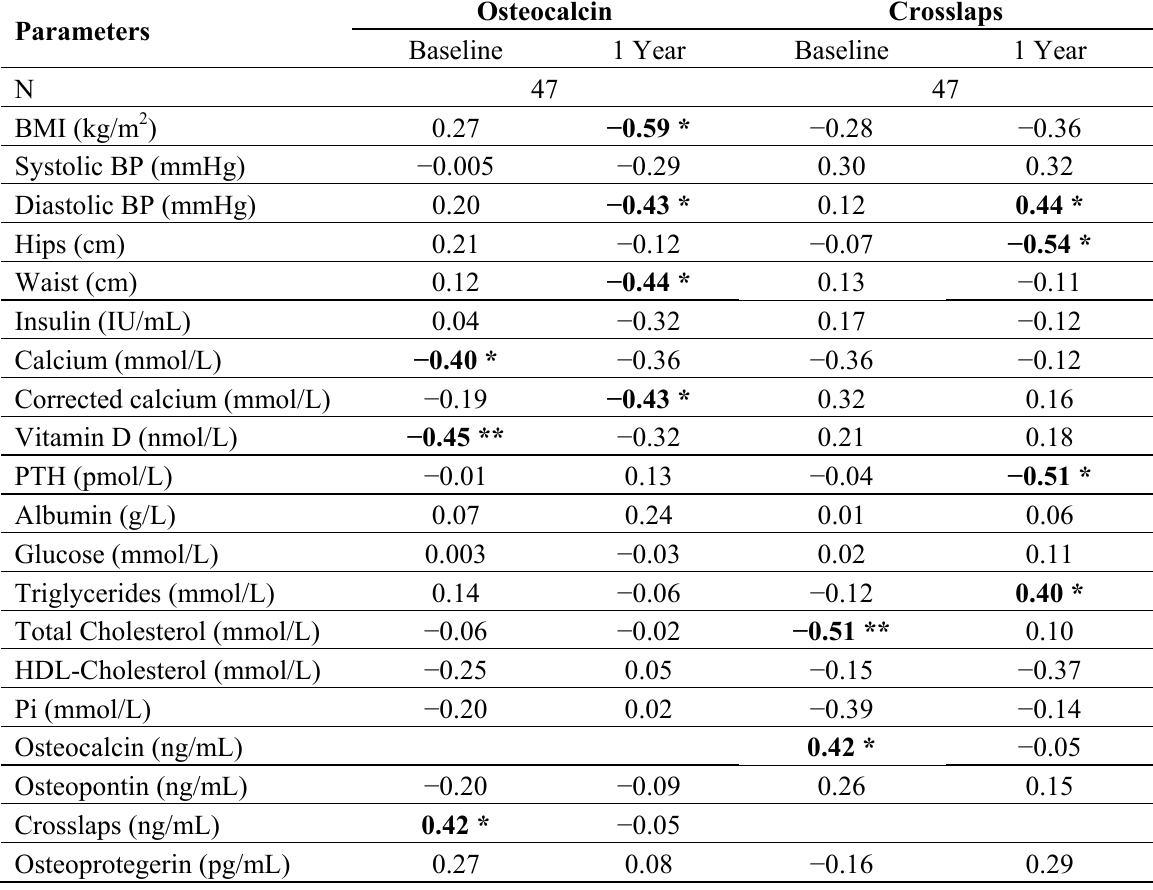
Table 2. Associations of Selected Parameters using Osteocalcin and Crosslaps as Dependent